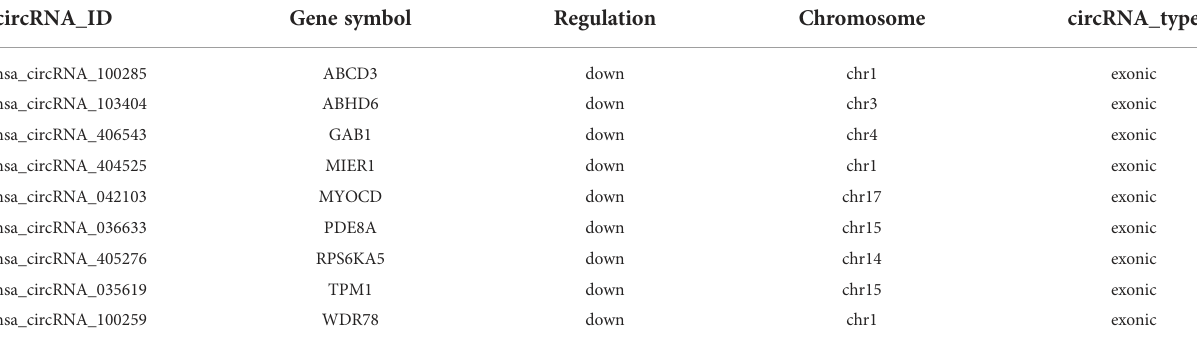
TABLE 1 Information on circRNAs formed by nine parental